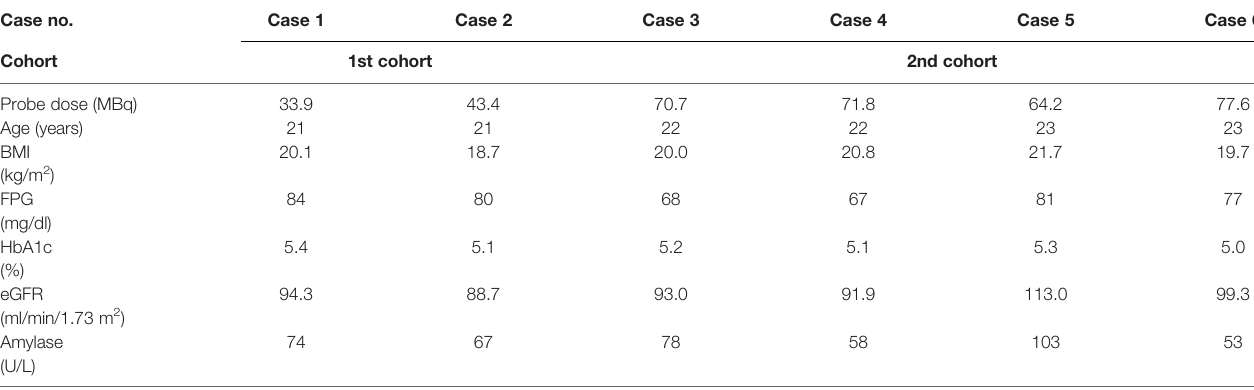
TABLE 1 | The baseline characteristics of the participants. Case